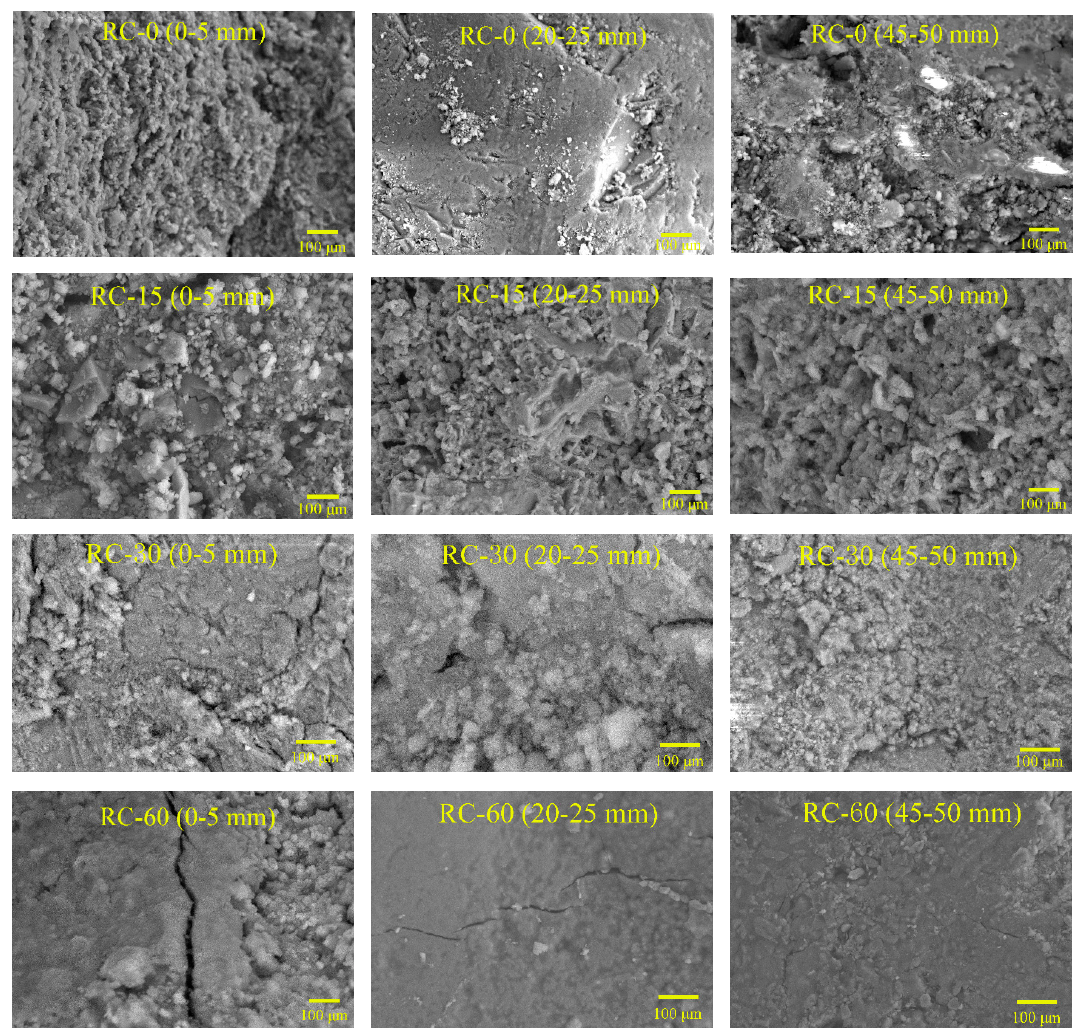
Figure 9. Scanning electron microscopy (SEM) images of NC concretes, after 0, 15, 30, and 60 cycles of sulfate attack (sample location from attack surface: 0–5 mm, 20–25 mm, and 45–50 mm).